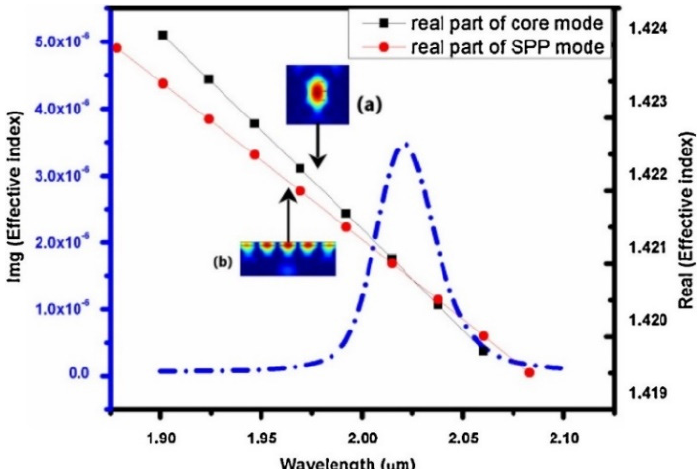
Figure 10. Coupling of silica (black dotted line), SPP (red dotted line), and the imaginary part of silica (blue dotted line) modes of maximum wavelength. Republished with permission from [96]; permission conveyed through Copyright Clearance Center,